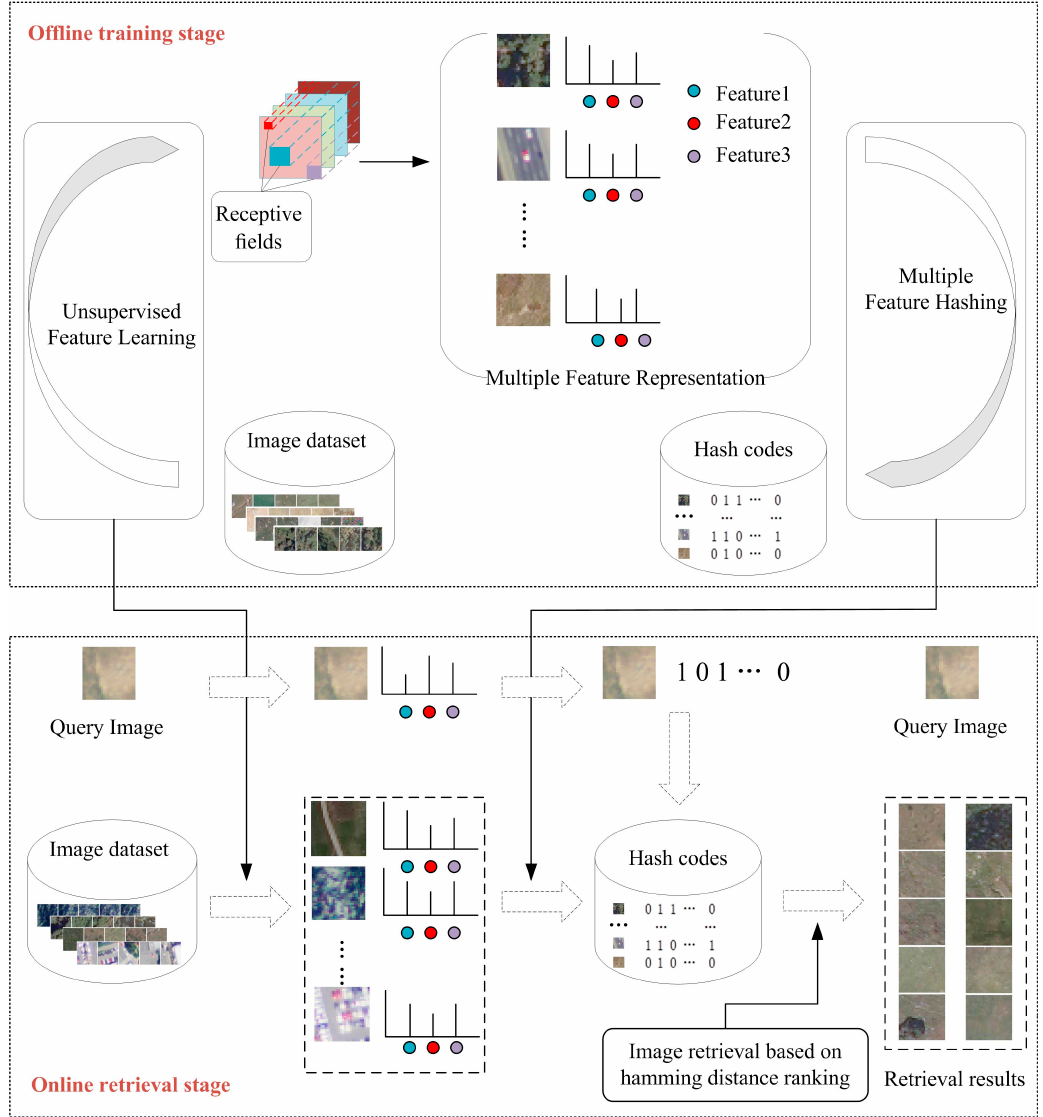
Figure 1. Flowchart of the proposed multiple feature hashing learning method for large-scale remote sensing image retrieval (MFH-LSRSIR).